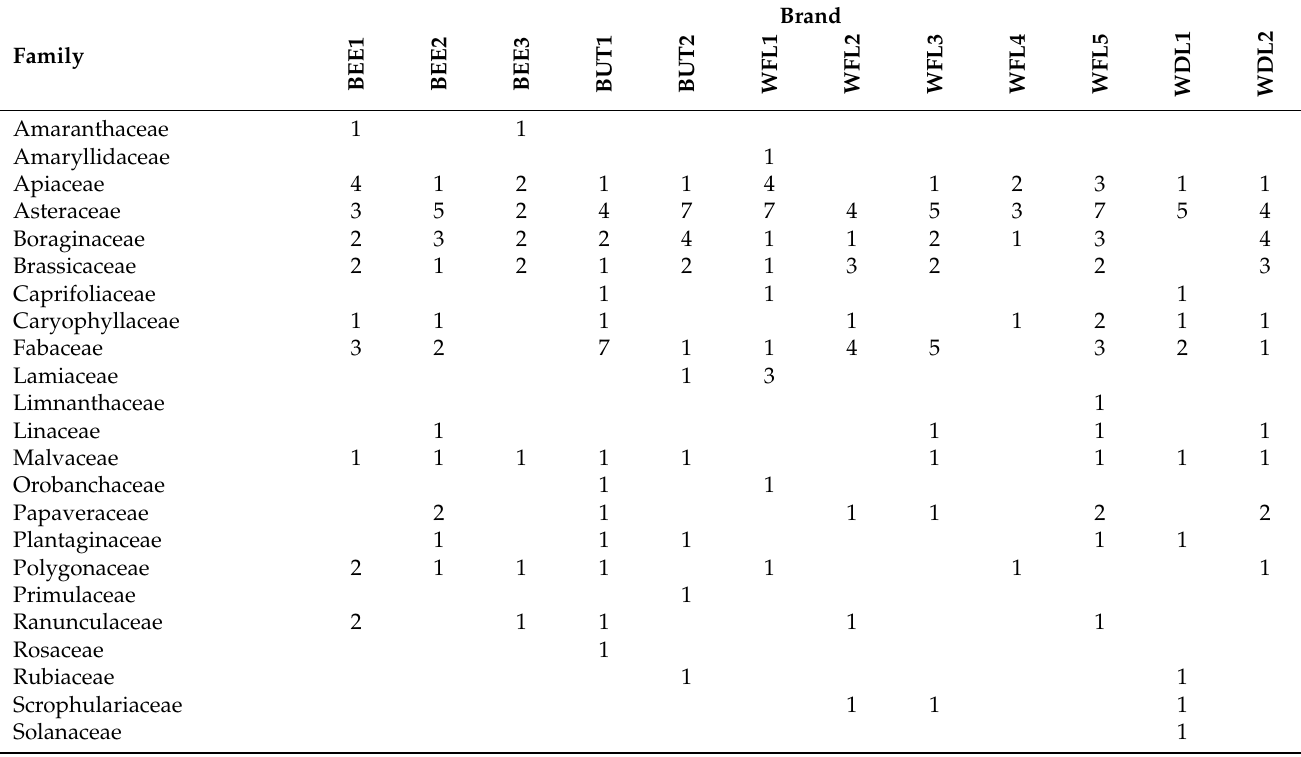
Table 3. Plant families found within twelve wildflower seed mixes purchased in Ireland in 2022. See Table 1 for details of each brand. Values given are numbers of species within each family found within two packets of seed of each